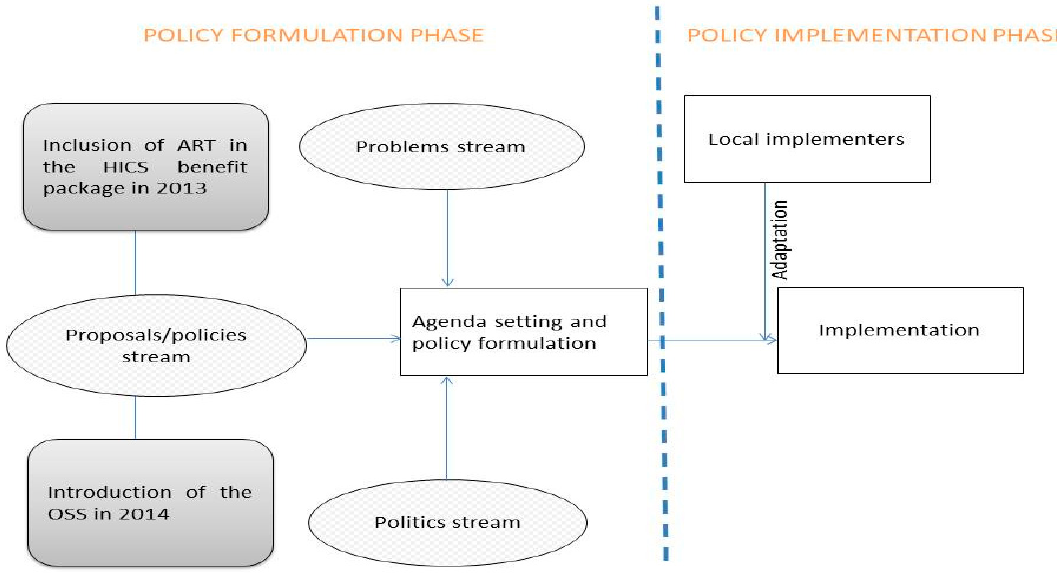
Figure 2. Conceptual framework. Source: adapted from Kingdon [16] and Lipsky [17].